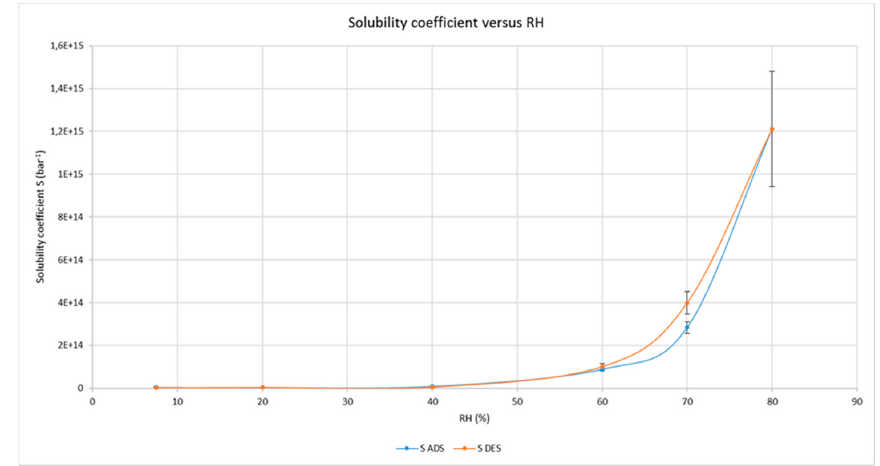
Figure 5. Oxygen solubility coefficients under different RH values, both in adsorption and desorption, through the CNCs coated PET film.